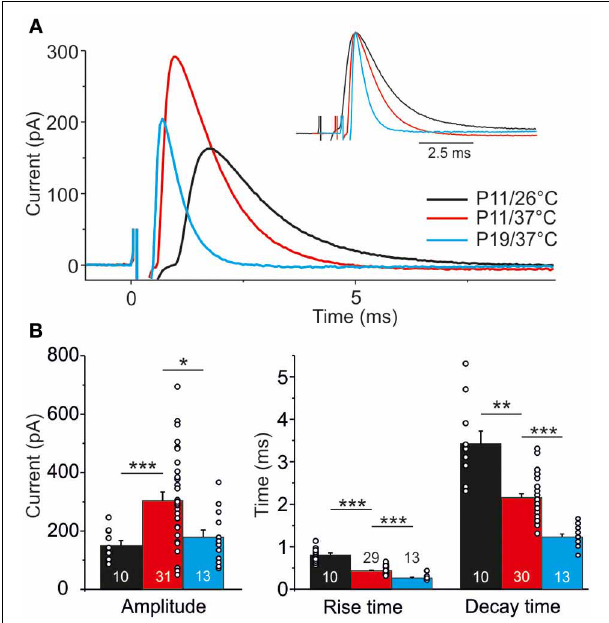
FIGURE 8 | Temperature dependency and age dependency of IPSC kinetics. (A) Average of 40 IPSCs obtained by 1Hz stimulation at P11/26 ◦ C (black), P11/37 ◦ C (red), and P19/37 ◦ C (blue). Each trace is obtained from a single, representative MNTB-LSO connection. 0ms corresponds to stimulus onset. Inset depicts traces with aligned peak amplitudes to better visualize differences in rise and decay time. (B) Statistical analysis of rise time, decay time, and peak amplitude. Numbers in bars depict the number of analyzed neurons, circles in bars depict single values. ∗ p < 0 . 05; ∗∗ p < 0 . 01; ∗∗∗ p < 0 .